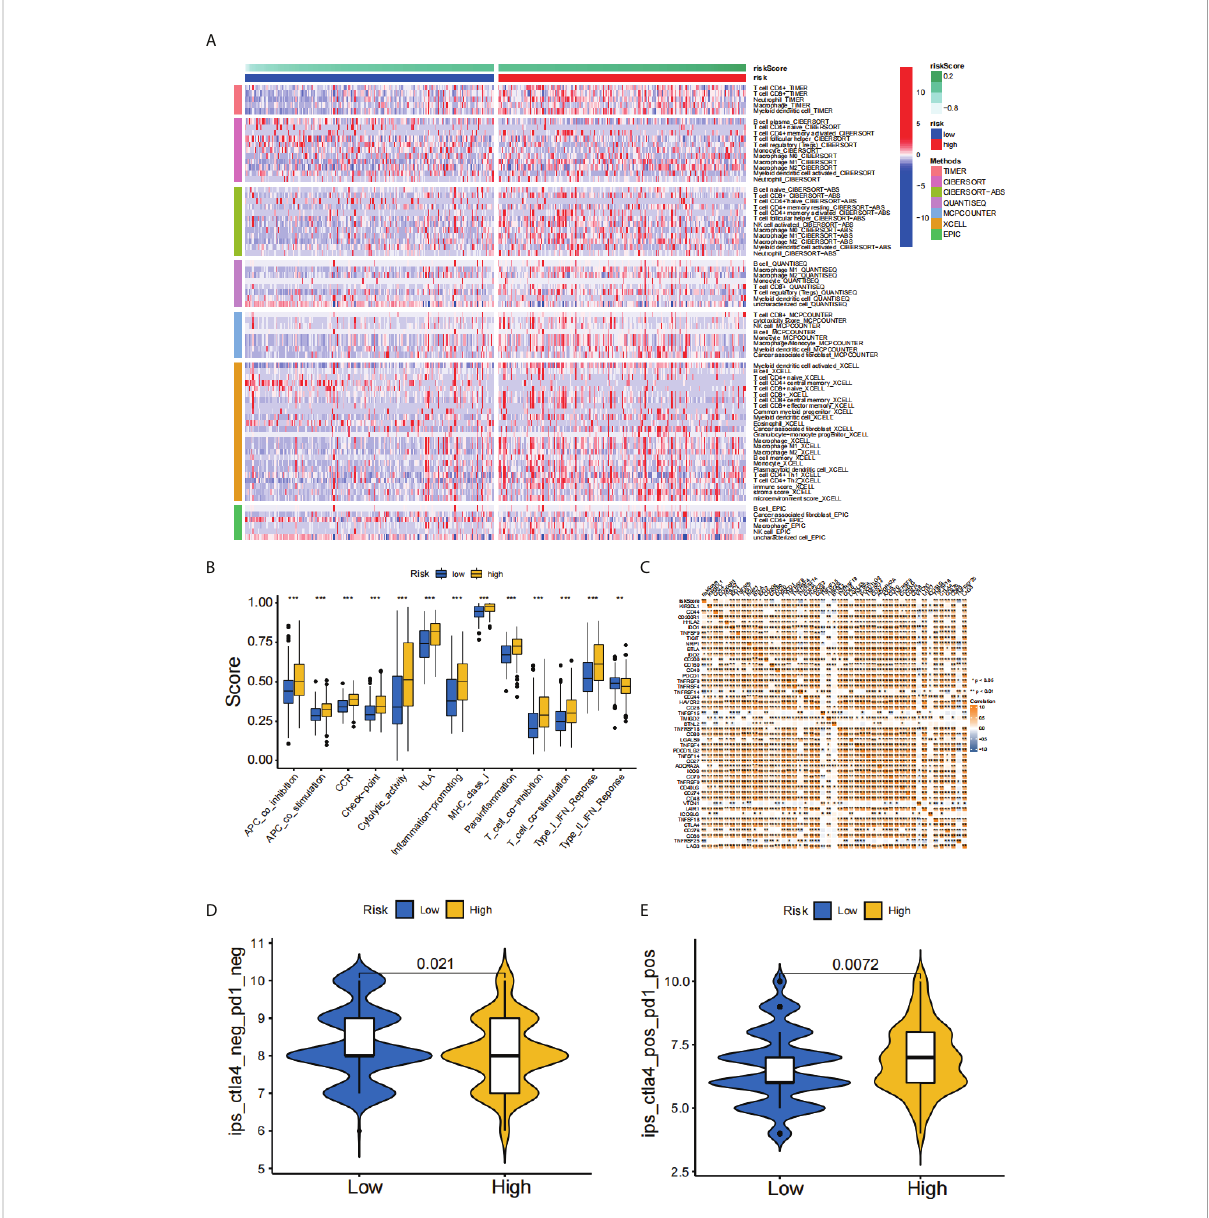
FIGURE 8 Analysis of immune landscape. (A) A heatmap for immunological responses between high- and low-risk groups. (B) Immune cell subpopulations and associated functions. (C) Expression of immune checkpoints in high- and low-risk cohorts. (D, E) Relative response of anti-PD-1 and anti- CTLA4 therapy between two groups. **p < 0.01; ***p <